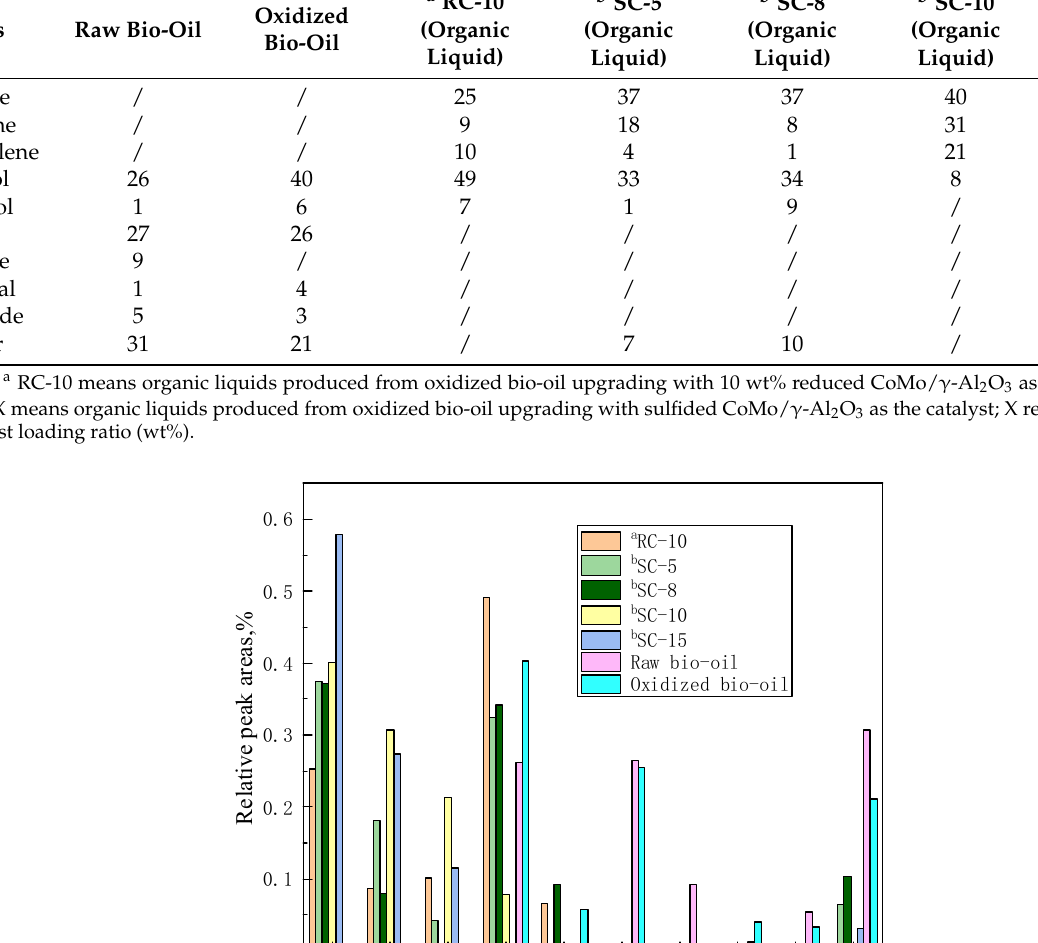
Table 3. Hydrodeoxygenation reaction exit gas components analysis by GC.